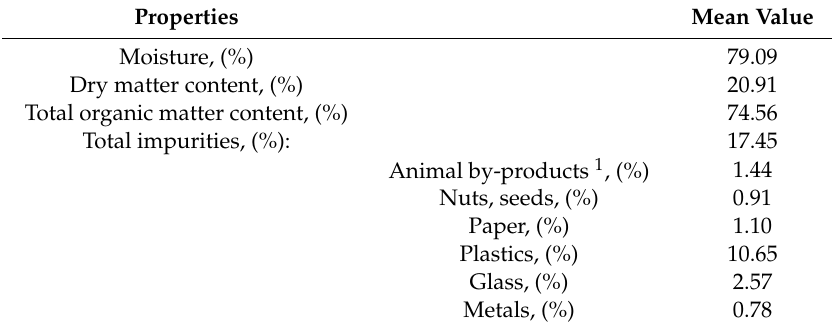
Table 3. Properties of biowaste collected in Warsaw in